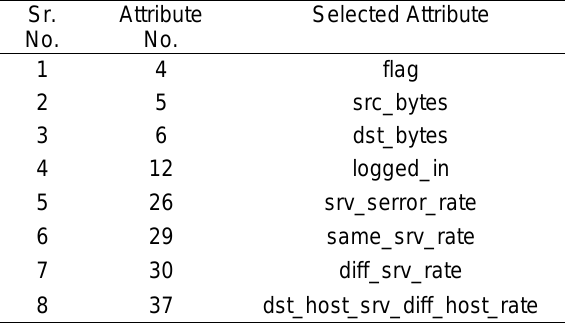
Table 1. Top 8 ranked features using Correlation-